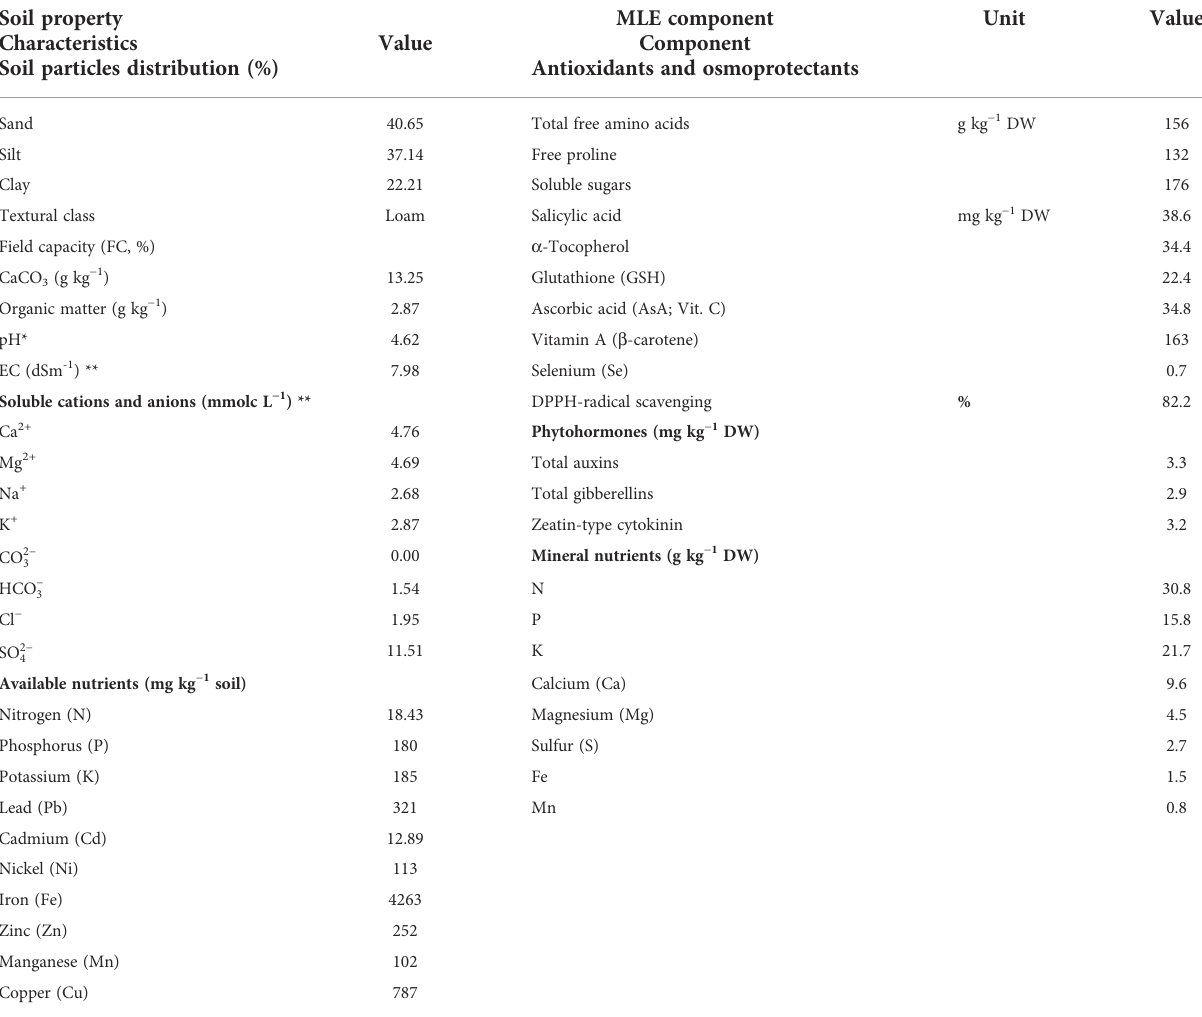
TABLE 1 Some physical and chemical properties of the investigated soil and chemical analysis of the moringa oleifera leaf extract